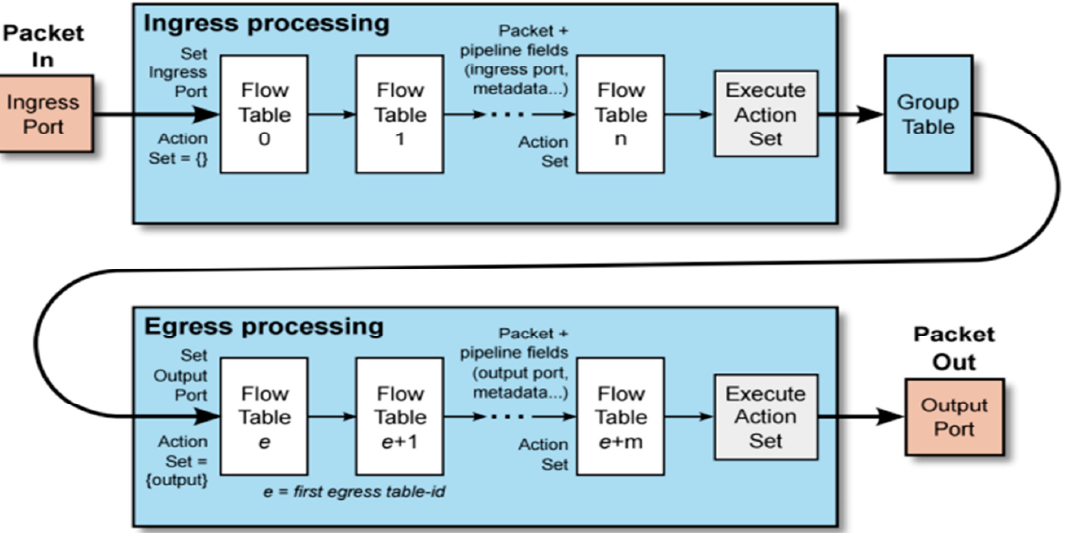
Figure 3. OpenFlow Packet Processing